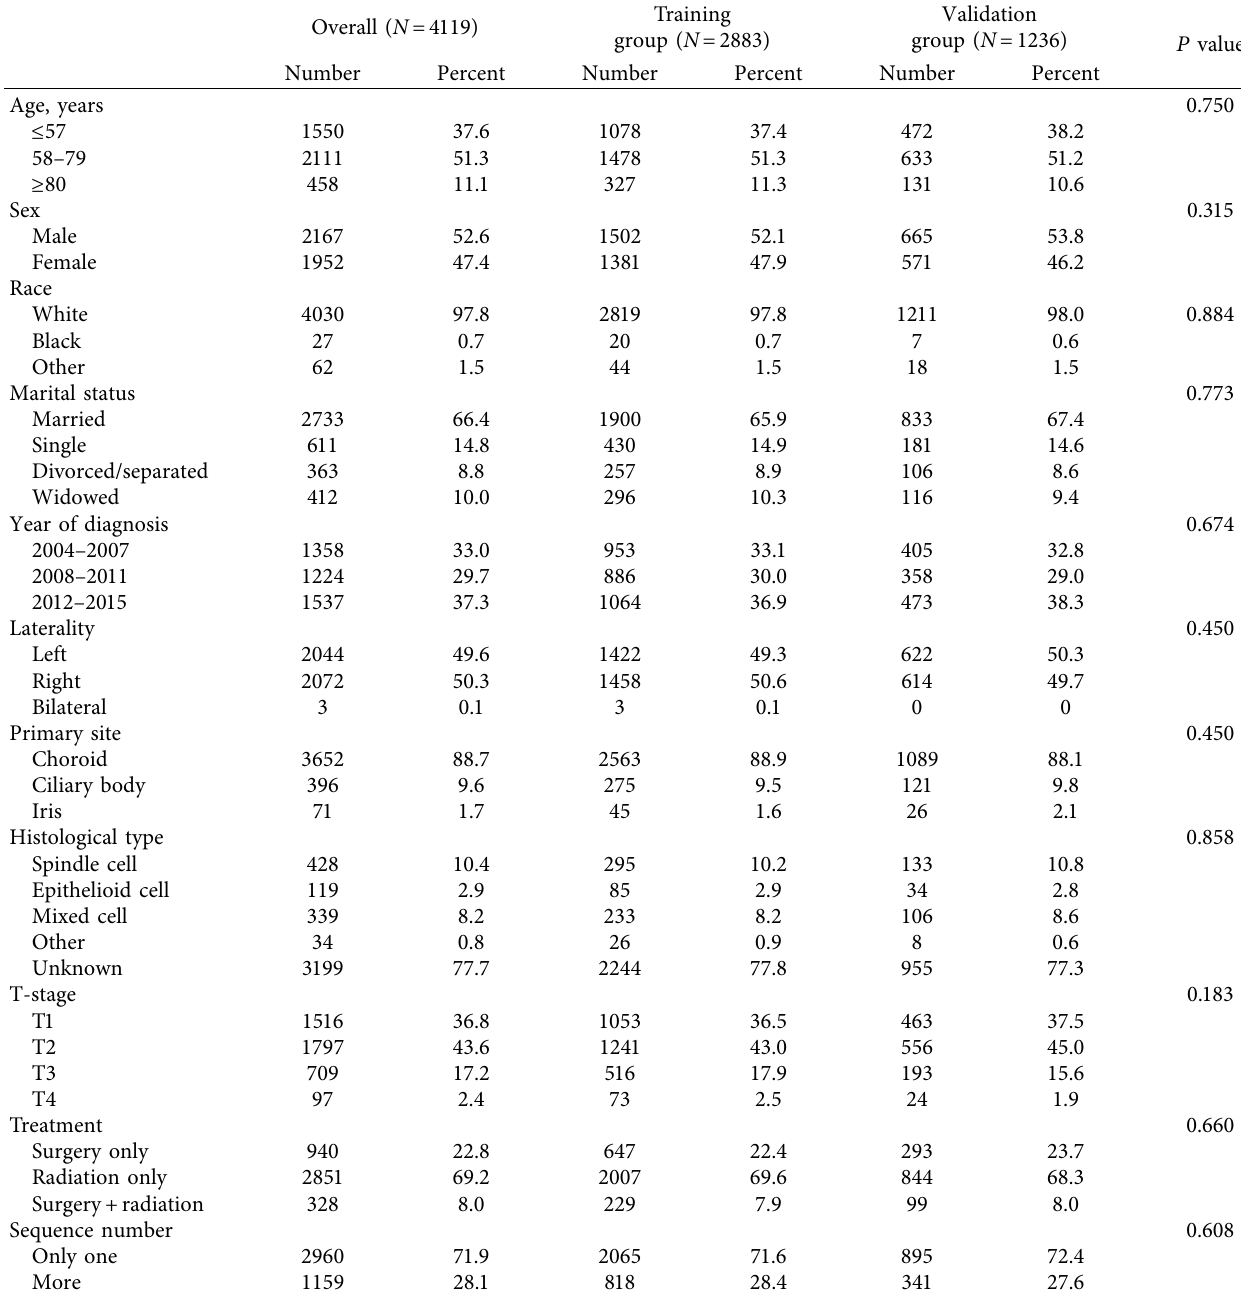
Table 1: Baseline characteristics of training group and validation